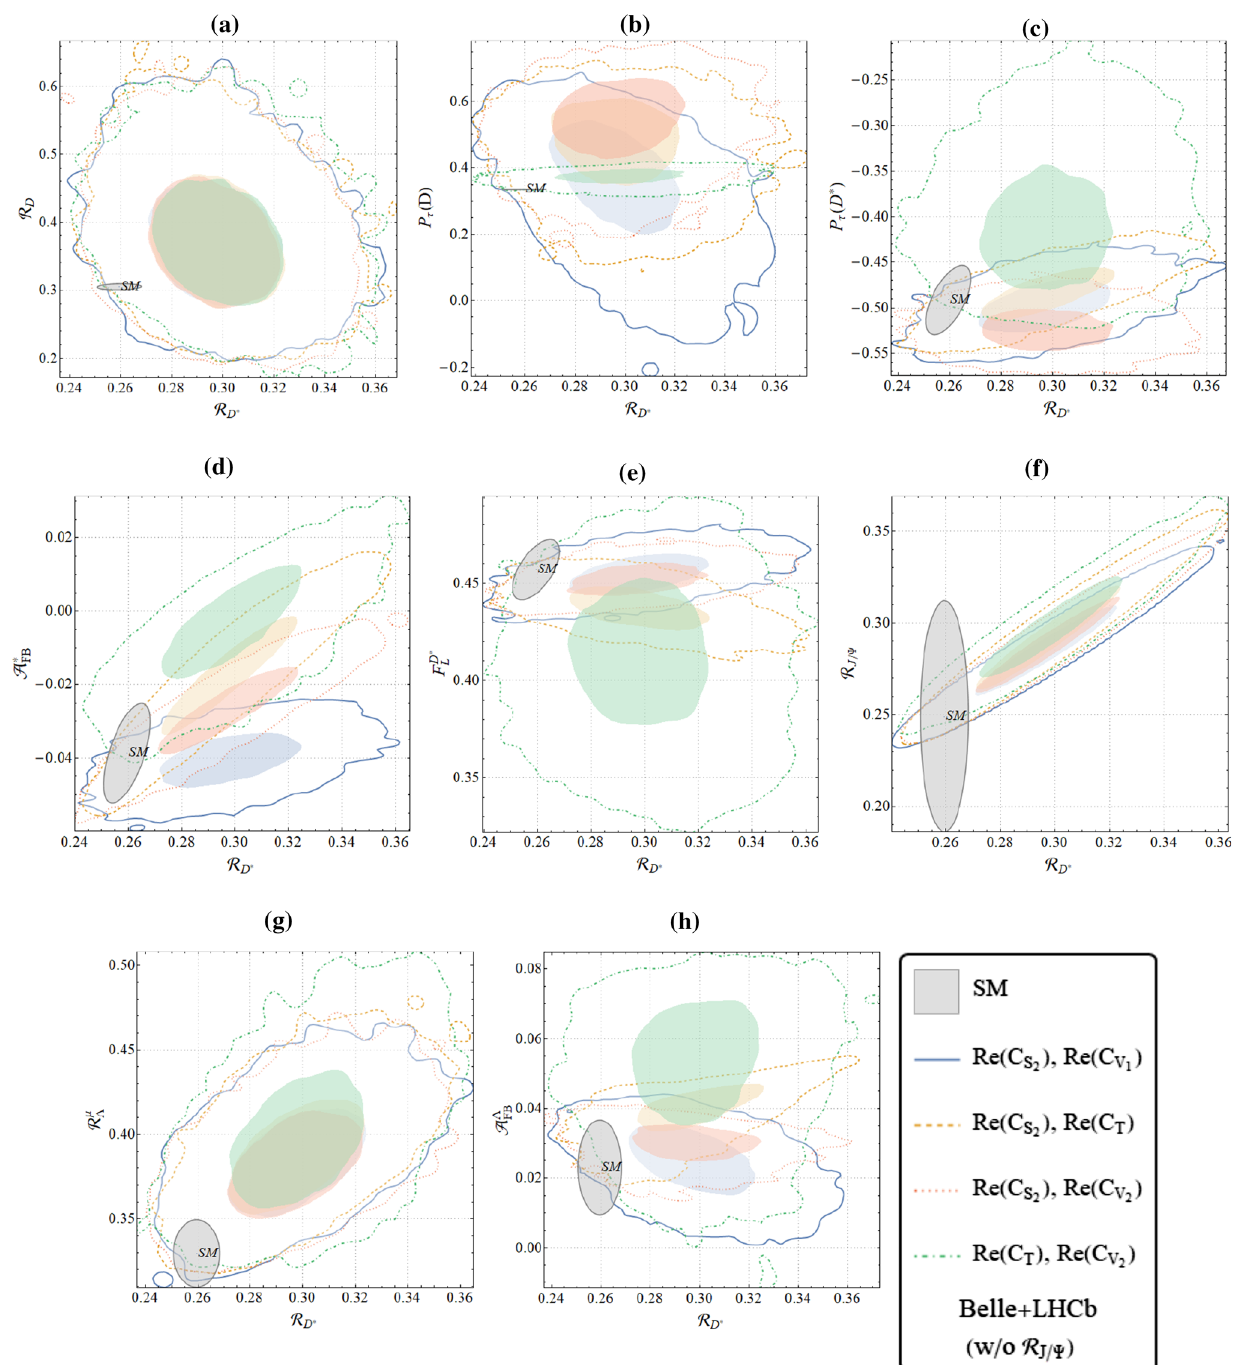
(cid:20) (cid:21) (cid:20) (cid:21) ), R e ( C ) ), R e ( C ) R e ( C R e ( C spondtothescenarioswith , , (cid:20) (cid:21) (cid:20) (cid:21) S 2 V 1 S 2 T ), R e ( C ) ), R e ( C ) R e ( C R e ( C and respectively.Foreachof S 2 V 2 T V 2 these scenarios, 1 σ (filled region) and 3 σ contours are